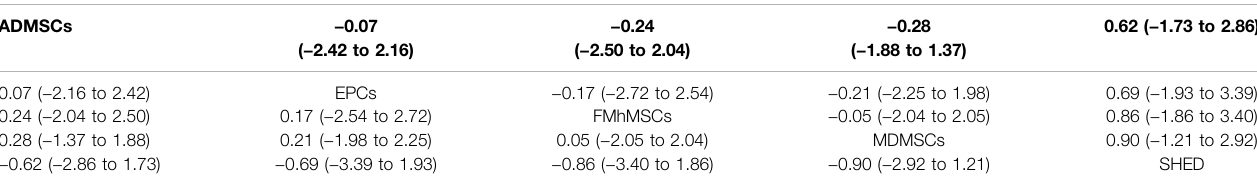
TABLE 14 | Network Meta-analysis results of histological Scores in stem cell groups in early stage after administration. ADMSCs −